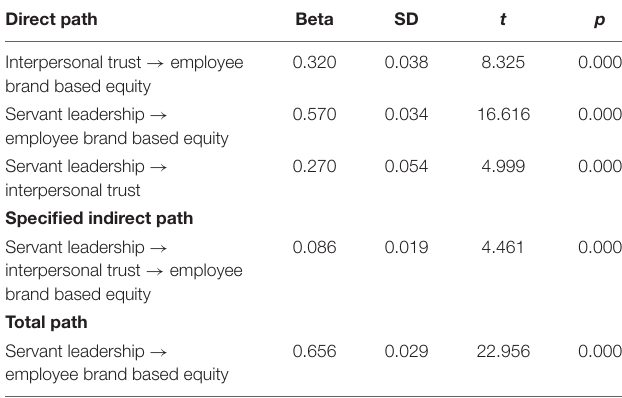
TABLE 4 | Direct, indirect, and total path